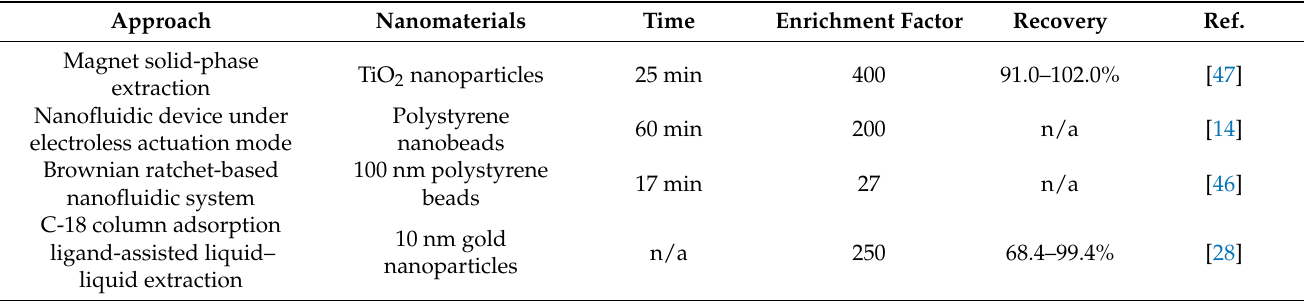
Table 1. Comparison of the performances of nanomaterial enrichment